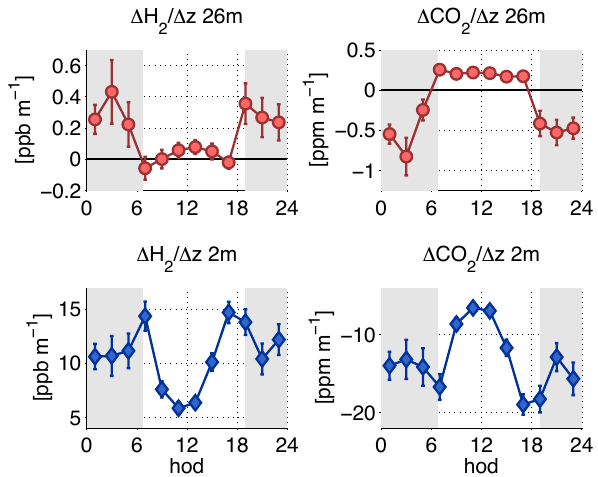
414 Figure 7. Two-hour mean mole fraction gradients of H 2 and CO 2 versus the hour of day 415 Figure 7. Two-hour mean mole fraction gradients of H 2 and CO 2 (hod) above (26 m) and below (2 m) the Harvard Forest canopy in July 2011. Bars 416 versus the hour of day (hod) above (26m) and below (2m) the Har- vard Forest canopy in July 2011. Bars indicate 95% confidence in- indicate 95% confidence interval of the sample mean of mole fraction gradients in 2-hour 417 terval of the sample mean of mole fraction gradients in 2h bins. bins. Grey shading designates nighttime hours. 418 Gray shading designates nighttime Higher signal-to-noise ratios could have been achieved for H 2 gradients measured 420 over a larger vertical height ( Δ z ) difference. However, the 4 m Δ z for the 24 m and 28 m 421 inlets was limited by the height of the tower above the forest canopy. Close to the soil 422 sink, H 2 gradients were greater in magnitude than the instrument precision. For future 423 studies, inlets below the canopy could be installed farther from the soils (> 0.5 m) and be 424 placed closer together ( Δ z < 3 m), to still measure statistically significant gradients that 425